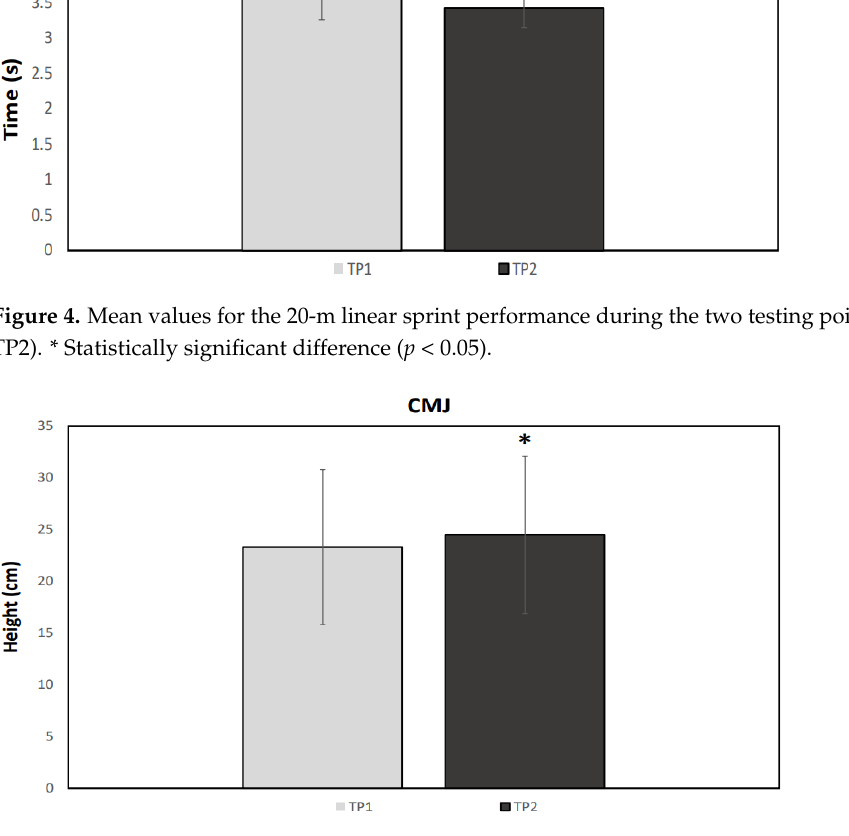
Figure 5. Mean values for the CMJ test performance during the two testing points (TP1 and TP2). * Statistically significant difference ( p <